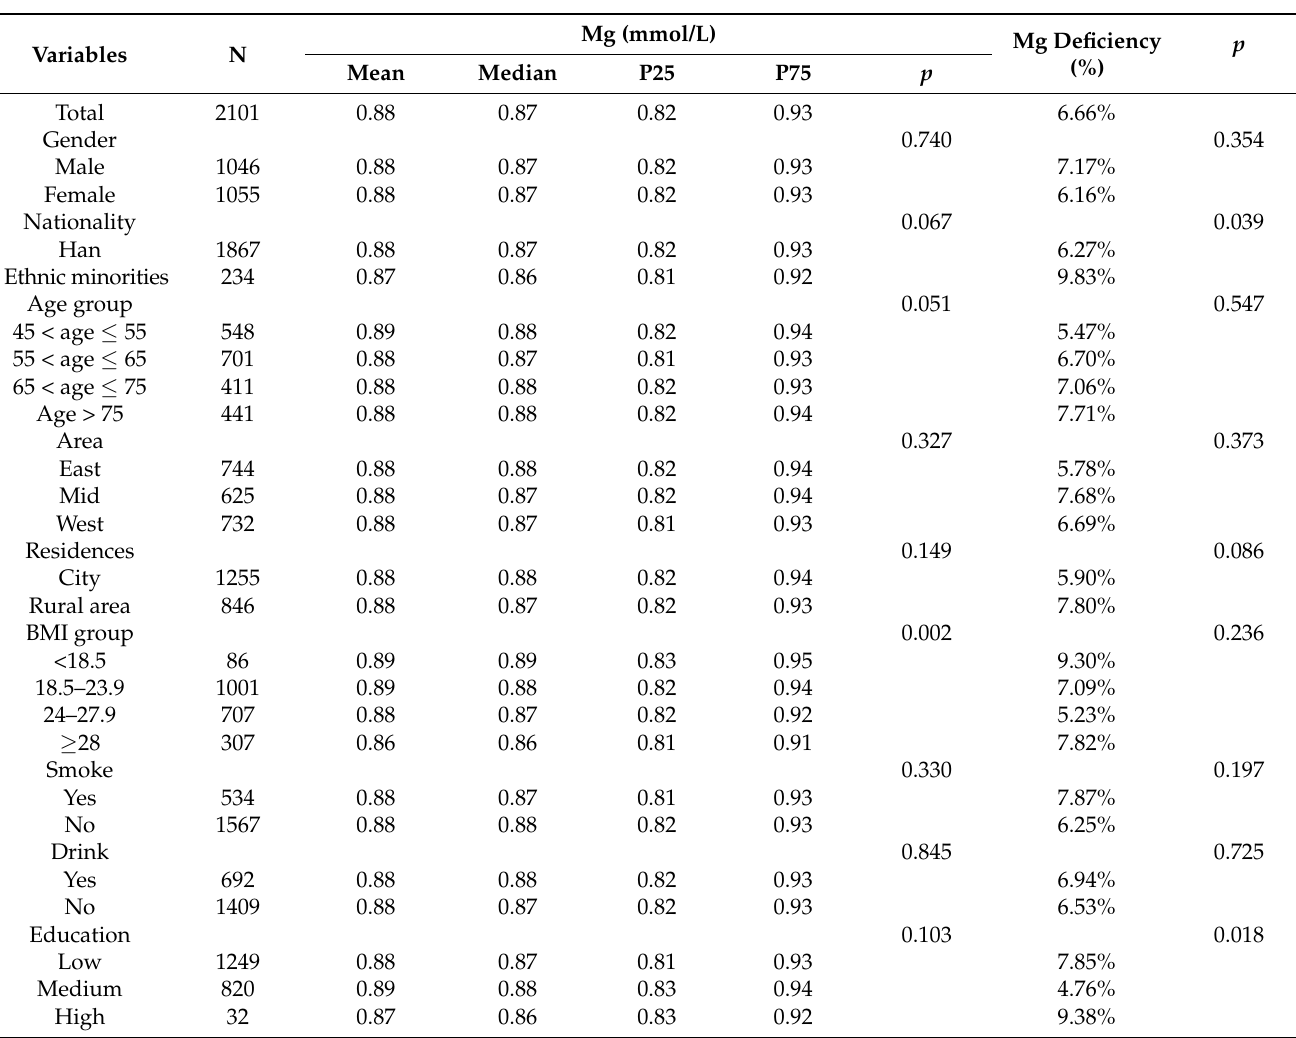
Table 4. Plasma magnesium concentrations and deficiency in the 2101